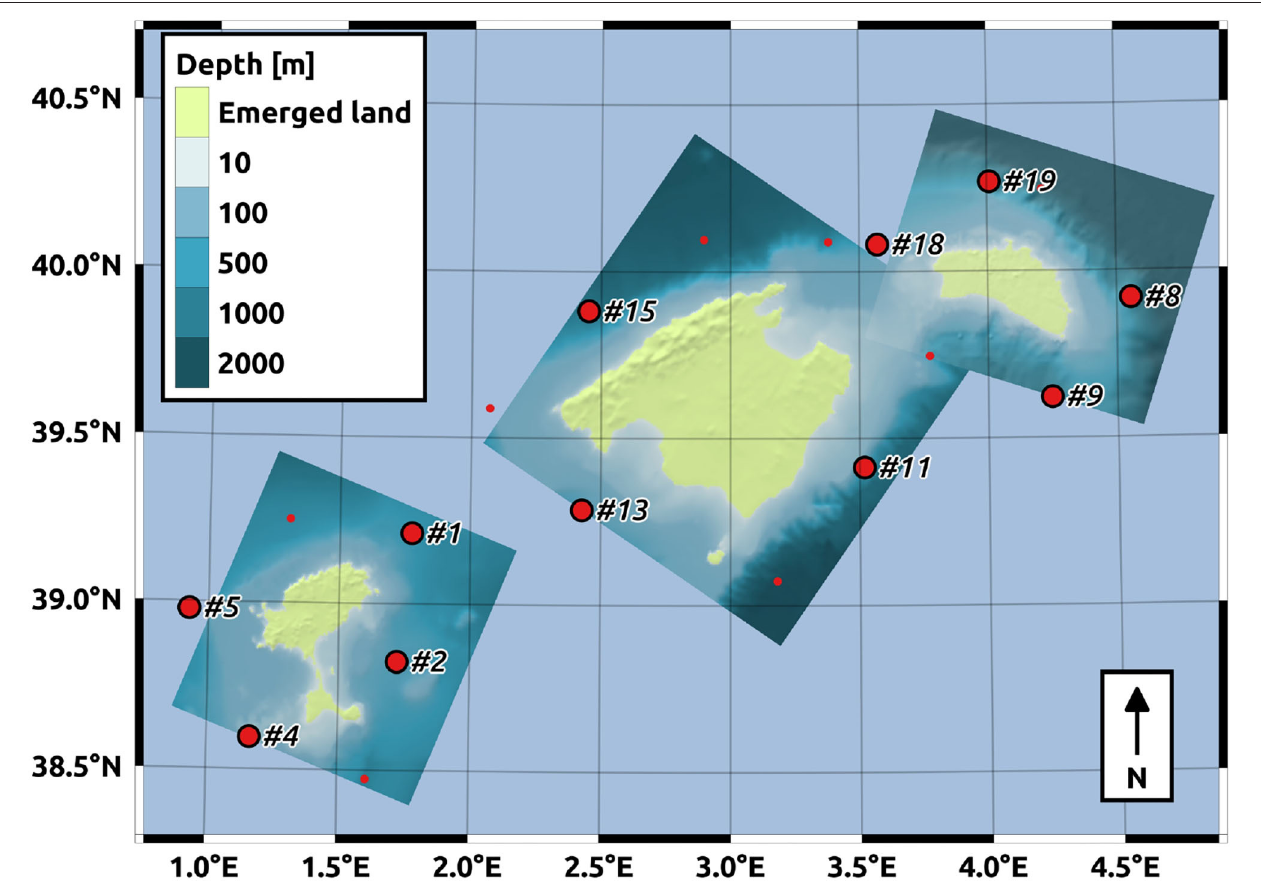
FIGURE 4 | Computational meshes used for wave propagation. Red dots indicate wave hindcast data points (Vousdoukas et al., 2017). Bigger dots indicate the data points we used for propagation (virtual buoys). Meshes are colored according to the